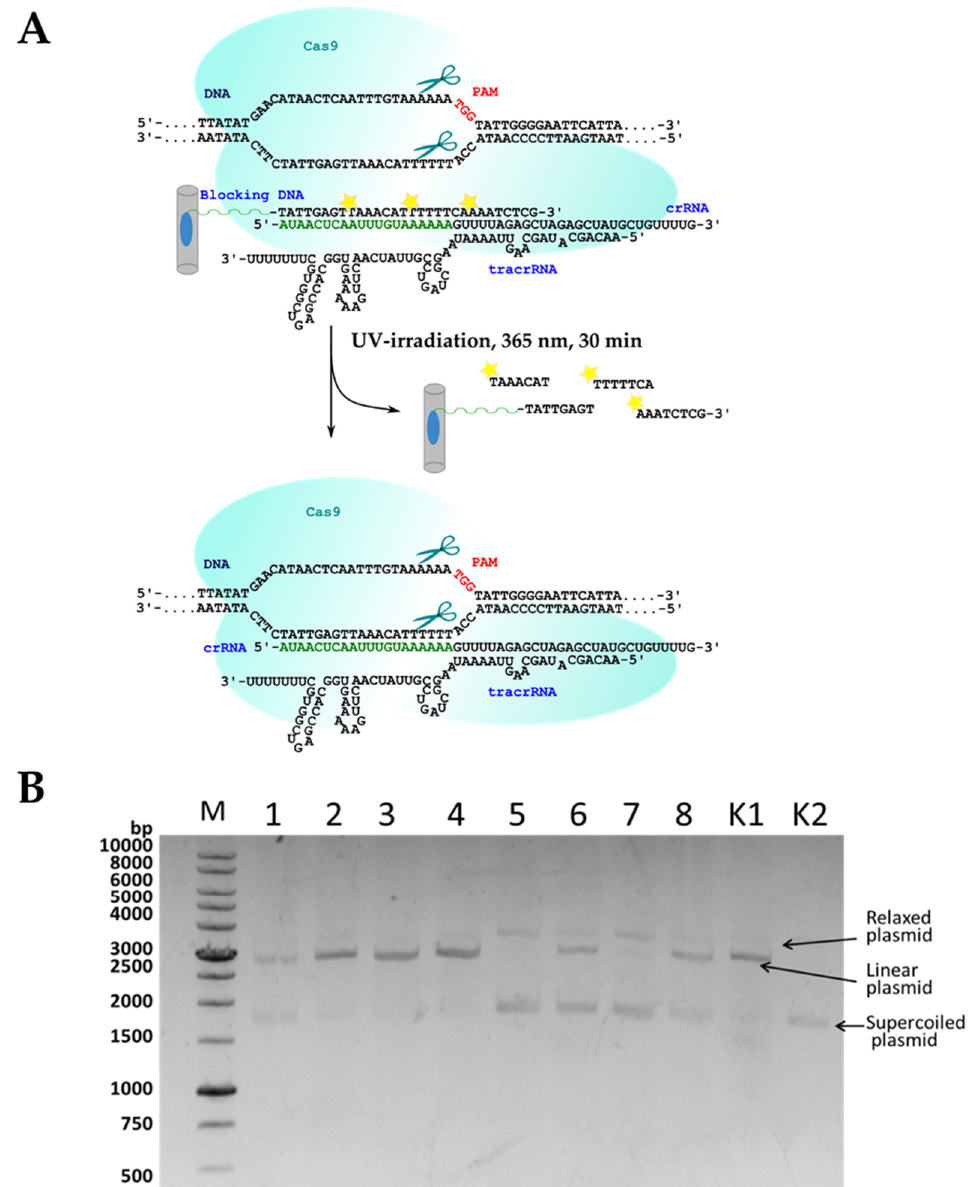
Figure 5. ( A ) The proposed mechanism of action of nanoCRISPR/Cas9 system. ( B ) Electropherogram of the cleavage products of the target DNA (a relaxed form of the plasmid that contained one nick, i.e., single-stranded break, and a linear form of the plasmid that contained a double-stranded break) after the action of crRNA/tracrRNA/Cas9. K1, the products of the cleavage of the target DNA with the Cas9 protein in the presence of tracrRNA and non-immobilized crRNAs, K2, initial target DNA plasmid, M, DNA marker. Cleavage of the plasmid supercoiled DNA target with Cas9 protein in the presence of tracrRNA and immobilized crRNA on SWCNT (lines 1, 5), SWCNT-COOH (lines 2, 6) or CEINP (lines 3, 7) or non-immobilized crRNA/B30_PL duplex (lines 4, 8) before (lines 5–8) and after (lines 1–4) irradiation at 365 nm. Conditions: 20 mM HEPES (pH 7.5), 100 mM KCl, 1 mM DTT, 0.5 mM Na 2 EDTA, 2 mM MgCl 2 , 5% glycerol. Cleavage of pBS2SKM by nanoCRISPR/Cas9 systems was performed at 37 °C for 1 h. Reaction mixtures were analyzed in agarose gel-electrophoresis.